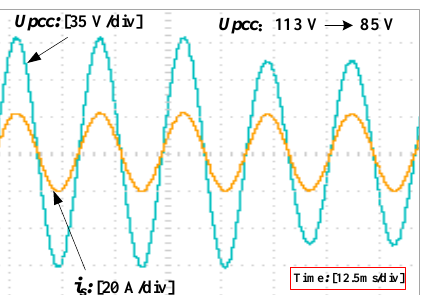
Figure 16. Waveforms of U PCC and i s with PLL when Z g = 1.8 mH. ( a ) i ∗ ϕ = 90 ◦ ; ( b ) i ∗ changes from 10 A to 20 A, ϕ = − 90 ◦ .